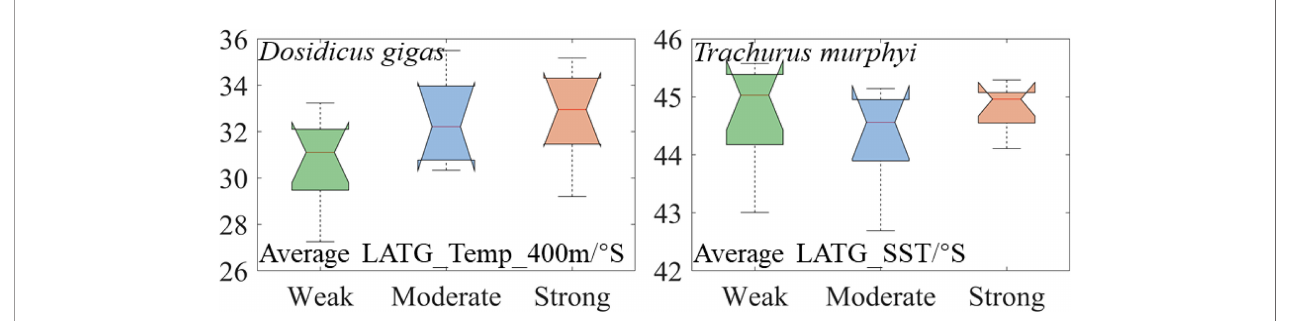
FIGURE 10 | Average latitude changes of the most preferred Temp_400 m of Dosidicus gigas and SST of Trachurus murphyi under El Niño events with different intensities. (The nodes of the boxplot from top to bottom are the upper edge, upper quartile, median, lower quartile, and lower edge, with “ + ” representing